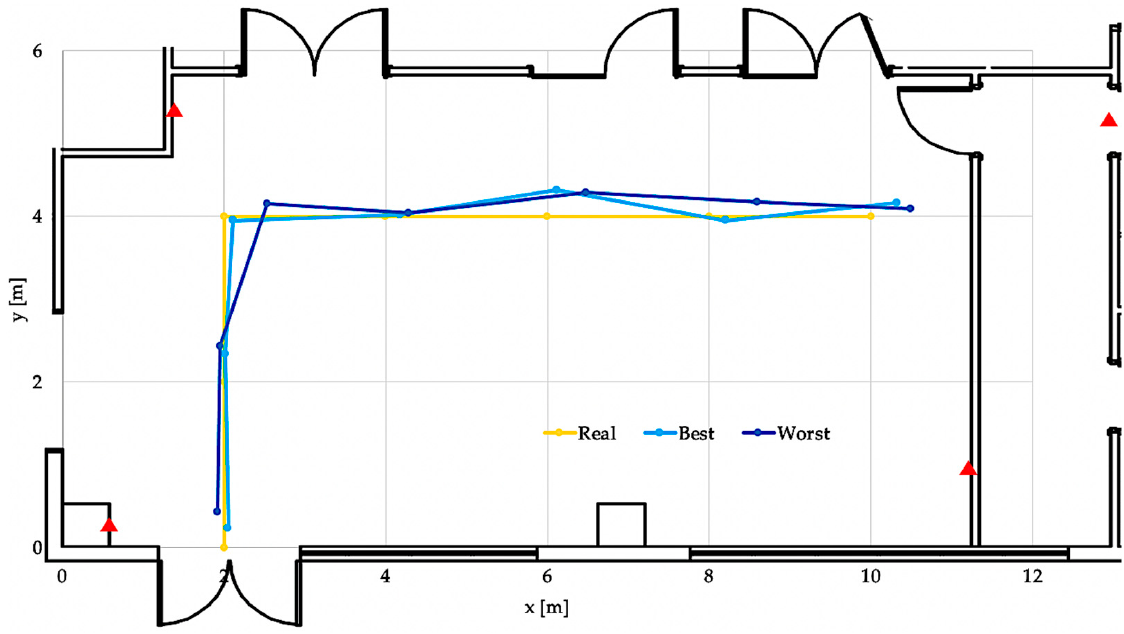
Figure 10. Real, best and worst routes computed by the RTLS system.